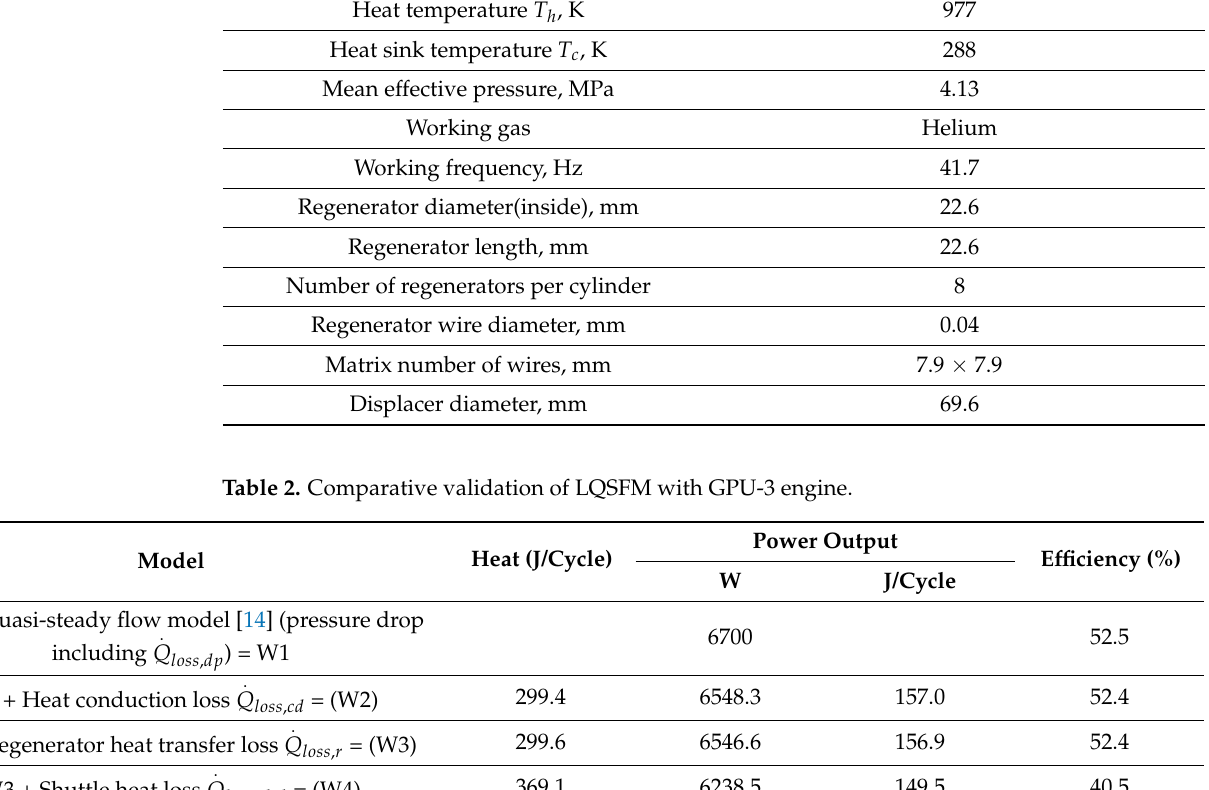
listed in Table 2. The average power output of the GPU-3 engine is equal to 5.48 kW. The average